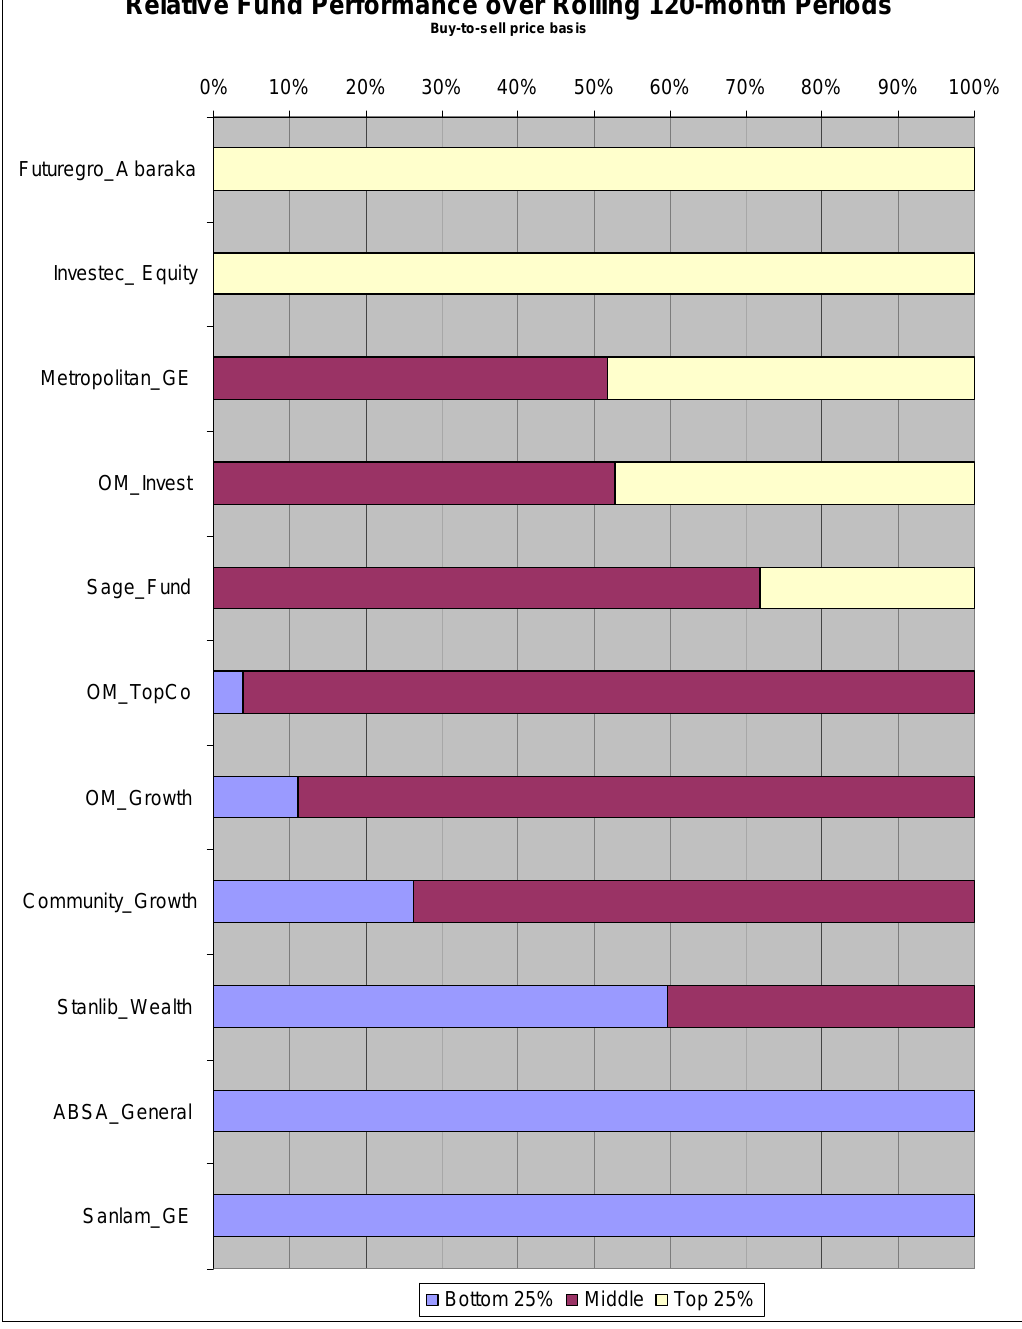
Figure 3: Quartile ranking of actively managed funds over rolling 120-month investment